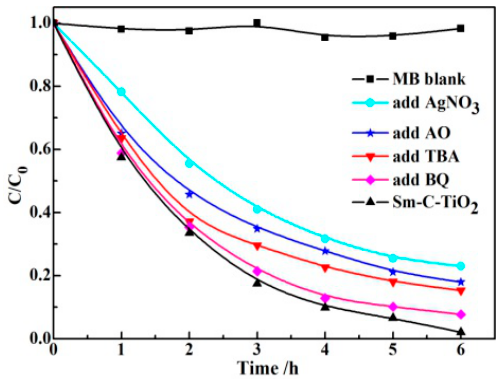
Figure 7. Photocatalytic degradation of MB over Sm-C-TiO 2 samples under visible light irradiation with the addition of different scavengers: MB blank, BQ, TBA, AO, and AgNO 3 .